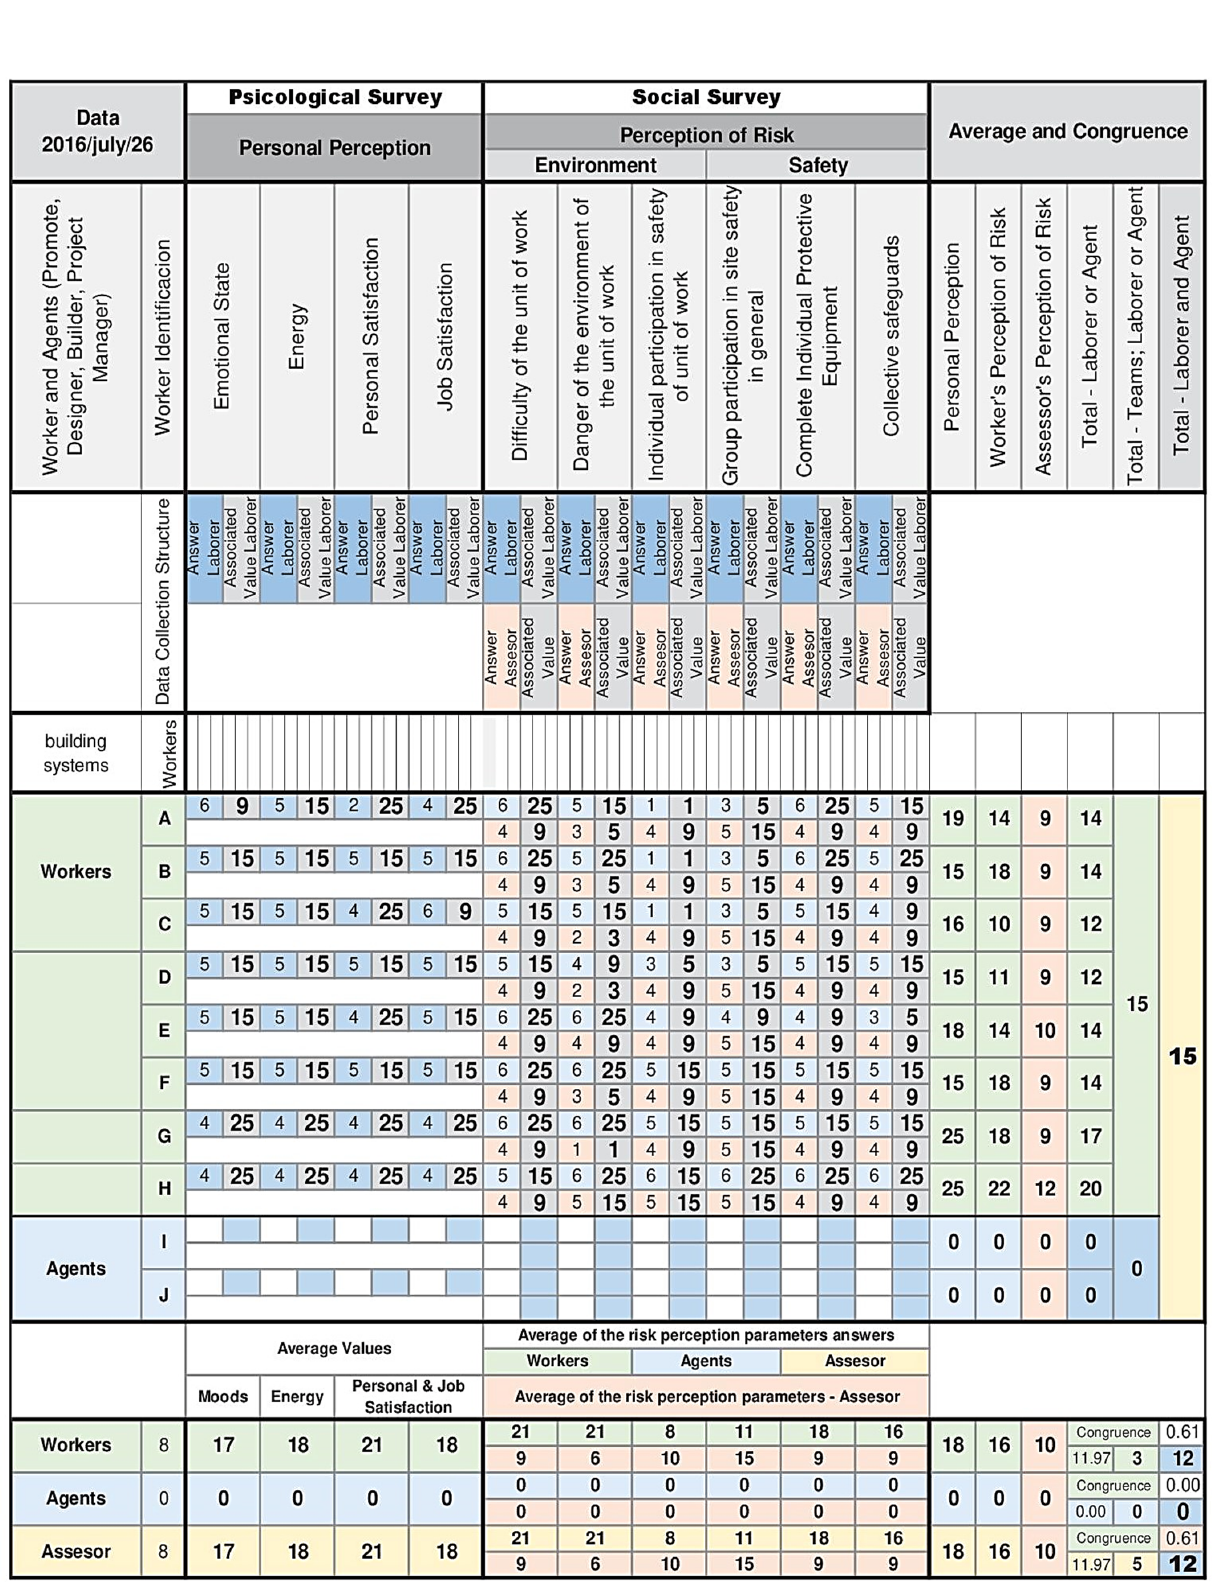
Figure A2. Help sheet for the survey for the calculation of the satisfaction level (Ls) parameter and the interpretation of results for the participatory interest (Ip) parameter .